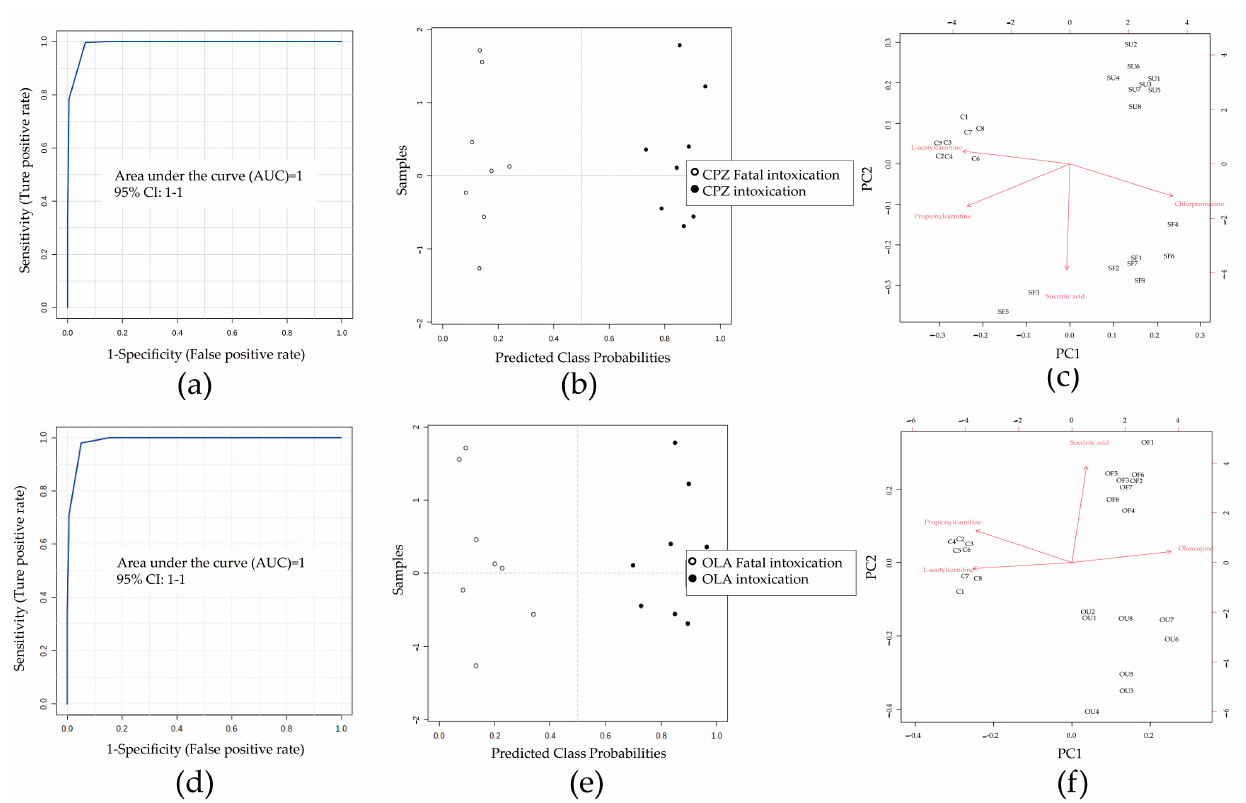
Figure 5. Contributions of three potential metabolites and antipsychotics in different life states at a low dose. ROC curves ( a , d ) and predicted class probabilities ( b , e ) show the differential performance between fatal intoxications and intoxications caused by CPZ ( a , b ; AUC: 1; 95%CI of AUC: 1–1) or OLA ( d , e ; AUC: 1; 95%CI of AUC: 1–1). PCA bi-plot showing scatters of samples (black font) from different life states based on three potential metabolites and antipsychotics (red font) profiles. Vector (red straight arrow) projections parallel to between groups show their discriminative power and arrows point in the direction of higher content. Further distinguishing of intoxication with fatal intoxications revealed that CPZ ( c ) or OLA ( f ) (red vectors) contributed less than succinic acid. n = 8, respectively. Abbreviations: SU: intoxications caused by CPZ at a low dose; SF: fatal intoxications caused by CPZ at a low dose; OU: intoxications caused by OLA at a low dose; OF: fatal intoxications caused by OLA at a low dose; C: controls.